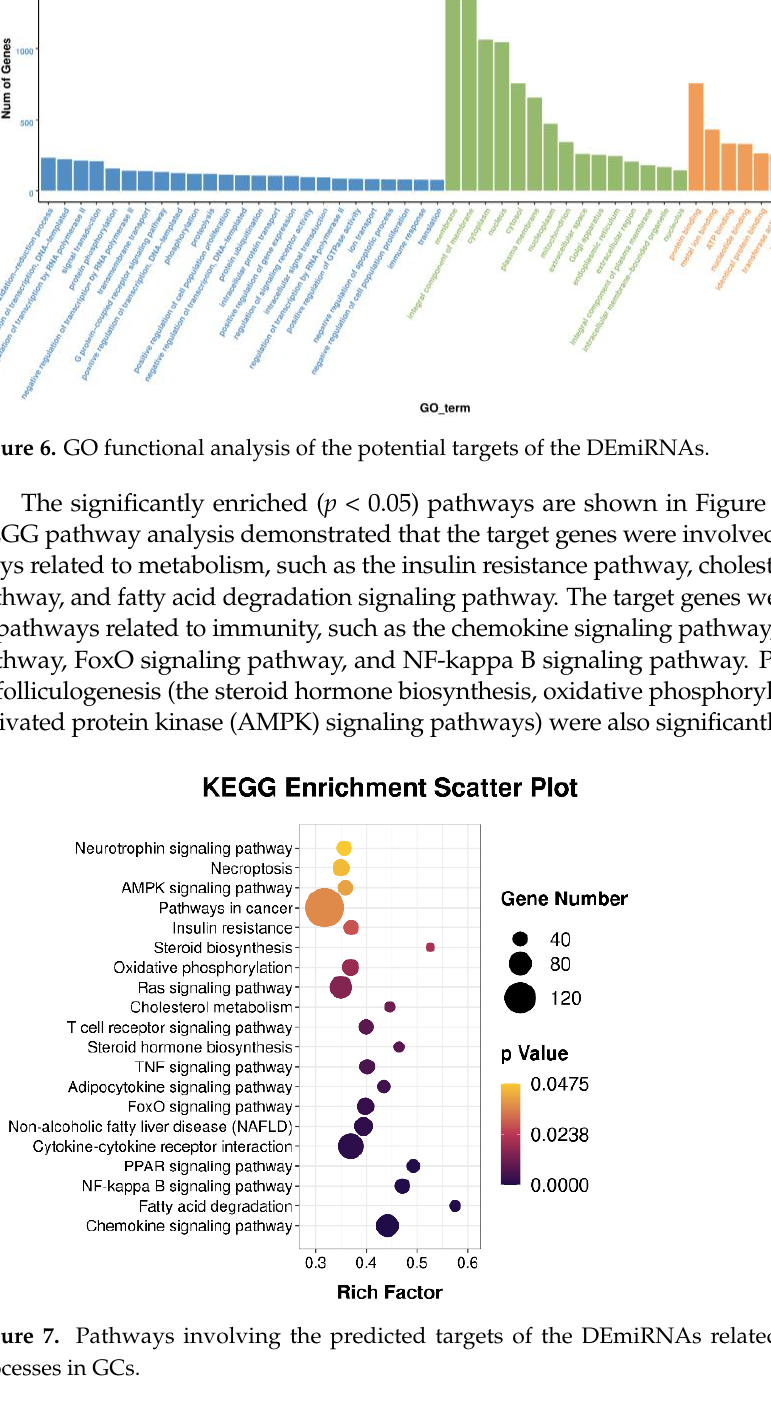
Figure 6. GO functional analysis of the potential targets of the DEmiRNAs.